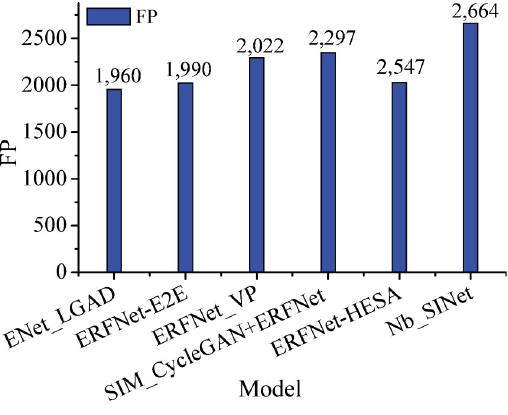
Fig 11. Comparison of the FP results obtained for the crossroad scenario.